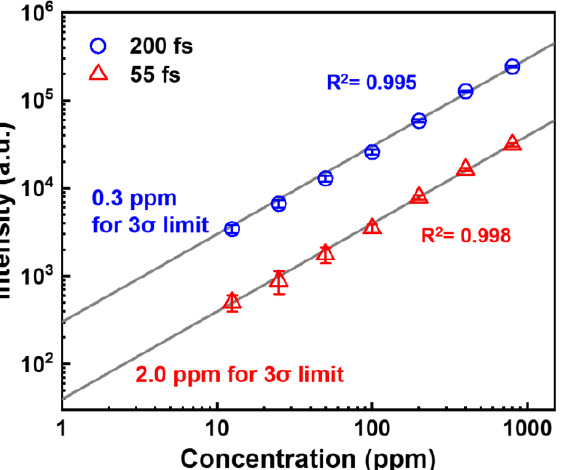
Figure 3. Dependences of the FIBS intensities on the Al concentrations for the chirp-free 55 fs (triangle) and negatively chirped 200 fs (circle) pulses.